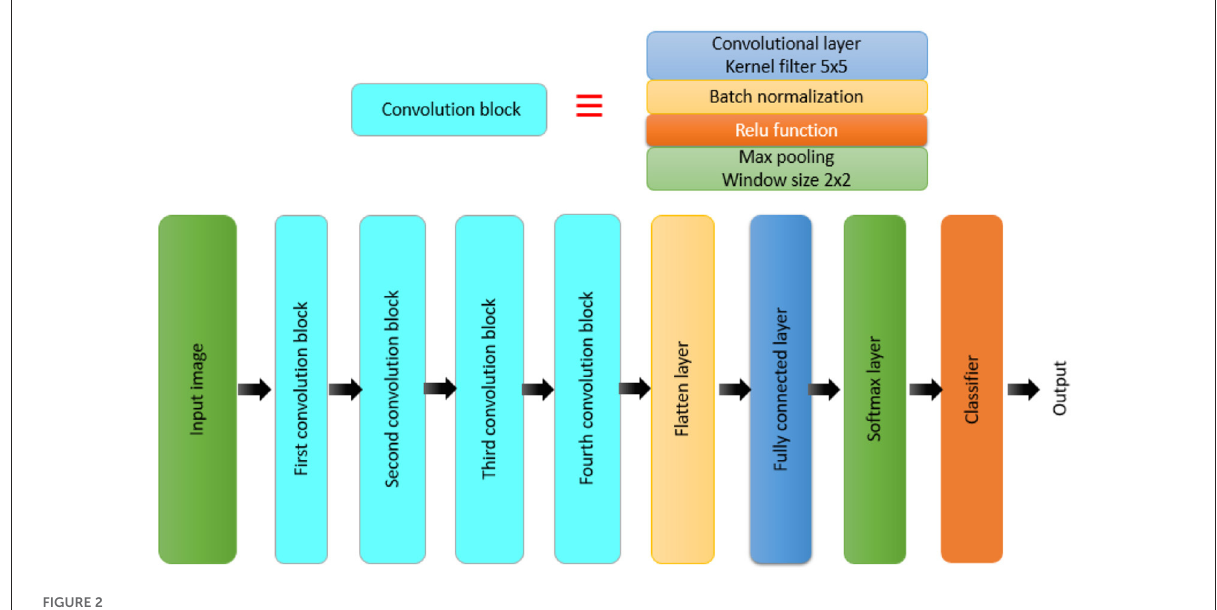
FIGURE2 Block diagram for the BRAIN-TUMOR-net